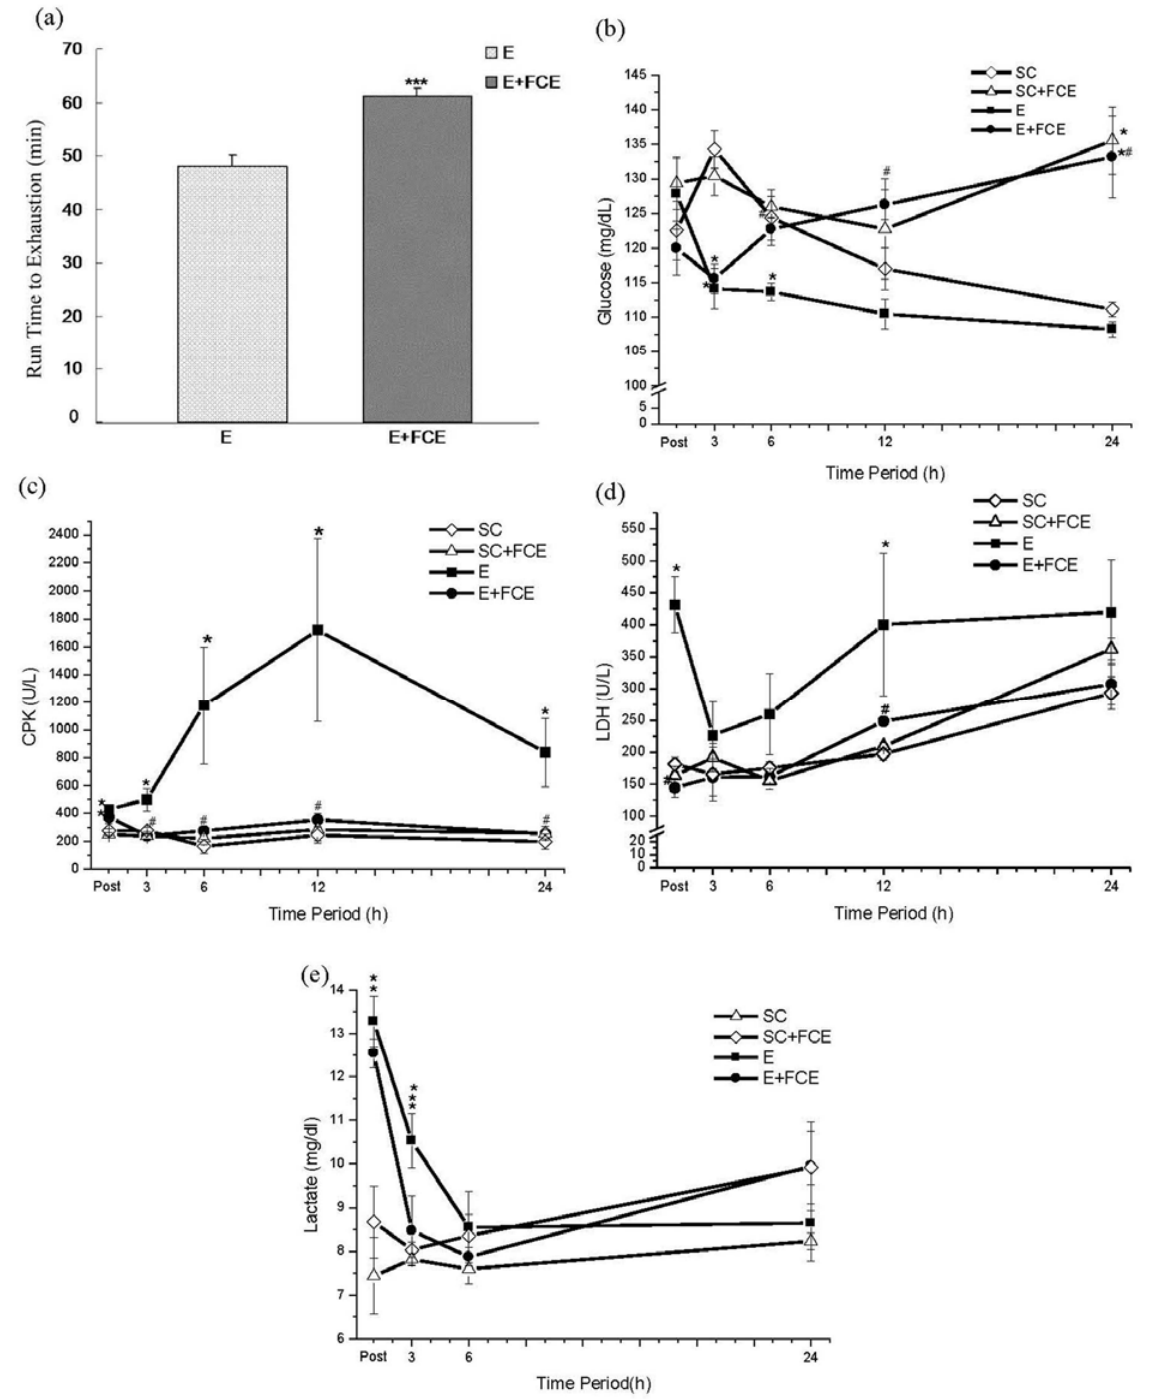
Figure 1. The run time to exhaustion on group E and E+FCE ( a ). Values are the means ± S.E.M.; n = 8. *** p < 0.001, compared with group E. Blood glucose ( b ), plasma CPK ( c ), plasma LDH ( d ) and plasma lactate ( e ) were obtained at several time points after exhaustive exercise. Values are the means ± S.E.M., * p < 0.05, compared with SC group; # p < 0.05, compared with E group. The E+FCE rats were treated with FCE at a dose of 20 mg/kg body weight via orogastric gavage for 7 consecutive days before an acute bout of exhaustive